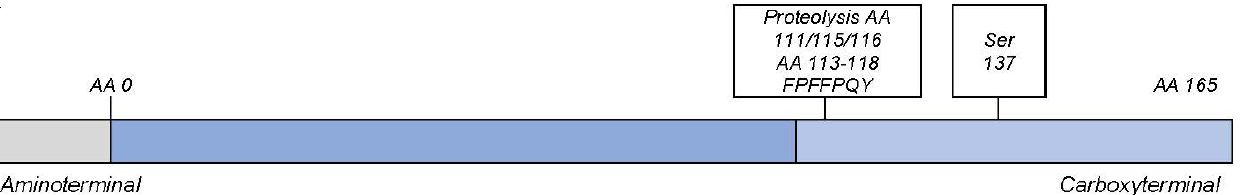
Figure 1. The structure of the endocan protein [3–5]. The mRNA encodes a propeptide including a signal peptide of 19 amino acids (grey color), whereas the complete secreted molecule includes 165 amino acids (dark blue plus light blue color). The molecule can be degraded by proteolytic cleav- age, resulting in the p14 endocan fragments (dark blue color) that include 111, 115, or 116 amino acids. The phenylalanine-rich region is also indicated in the figure (amino acids 113–118). The dermatan sulfate chain is linked to Ser 137; this glycan chain has a molecular weight of 15–40 kDa.